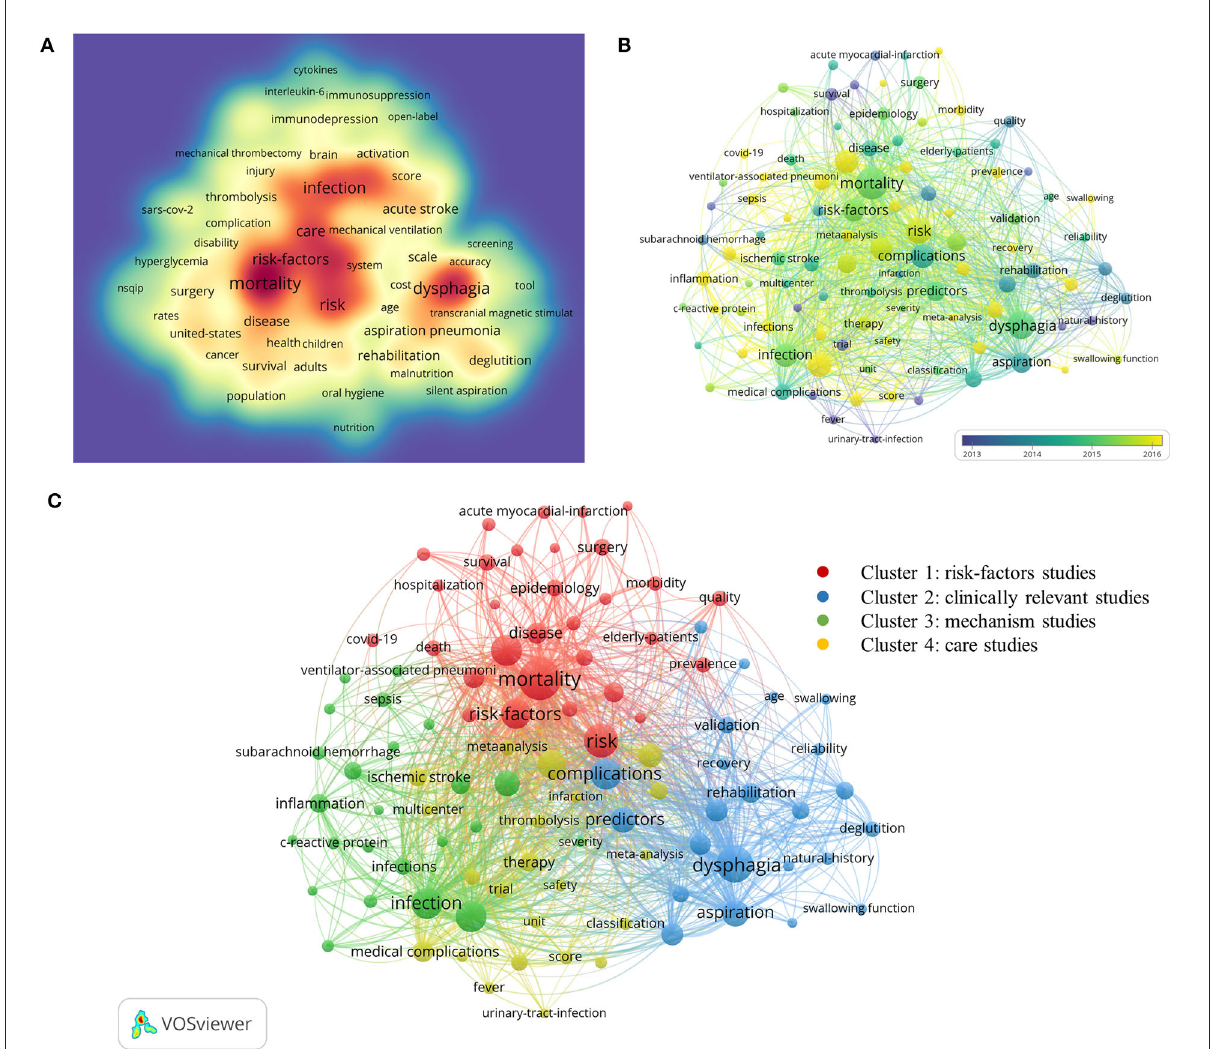
FIGURE10 (A) The density visualization map of 240 keywords with more than 10 co-occurrences. (B) The overlay visualization map of 100 keywords with more than 20 co-occurrences. (C) The network visualization map of four clusters of 100 keywords created by VOS